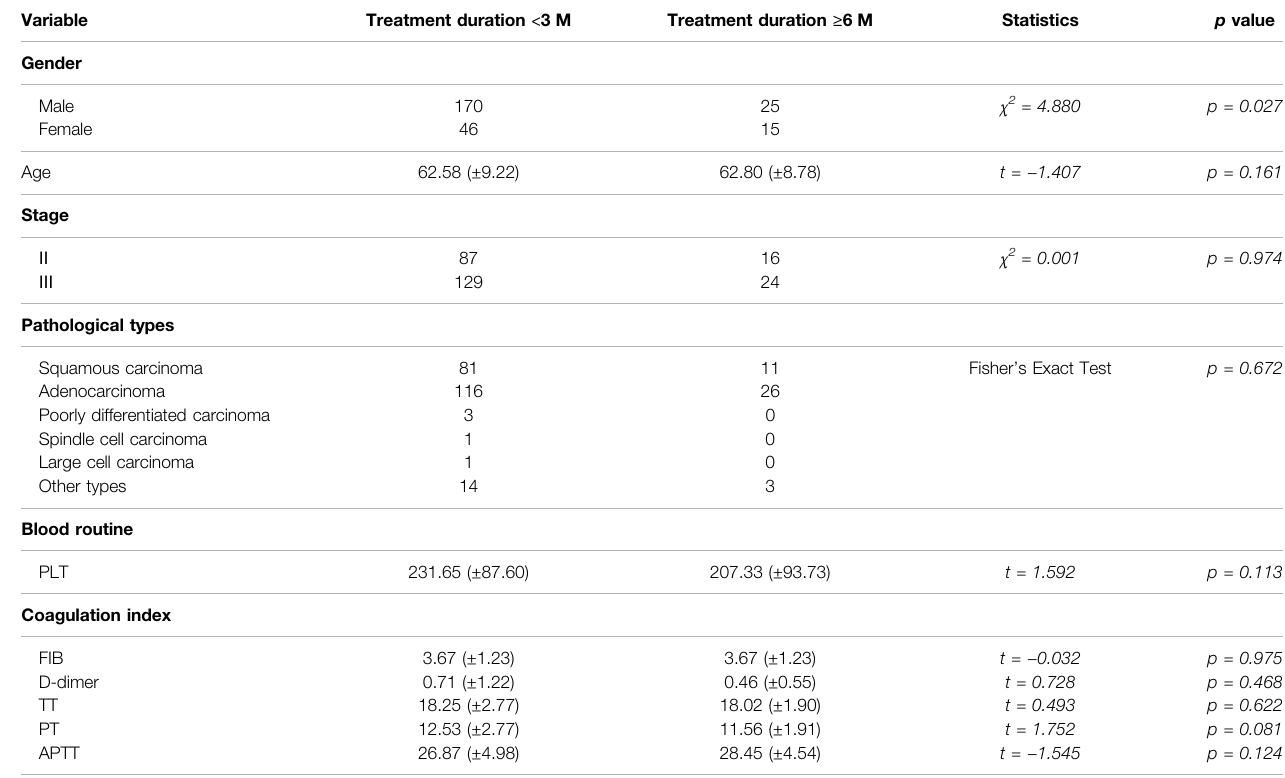
TABLE 5 | Baseline comparison between the HSOL use for < 3 months and ≥ 6 months